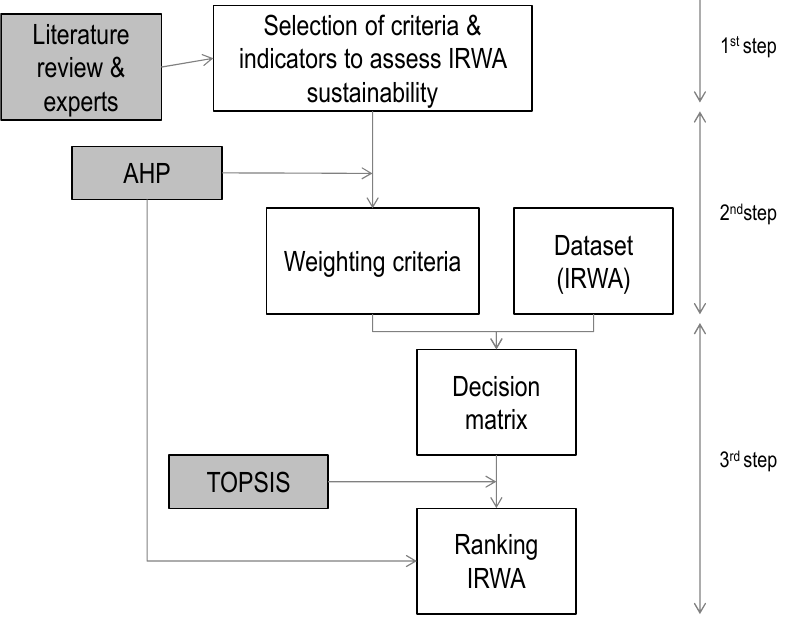
Figure 2. Outline of the methodological approach.